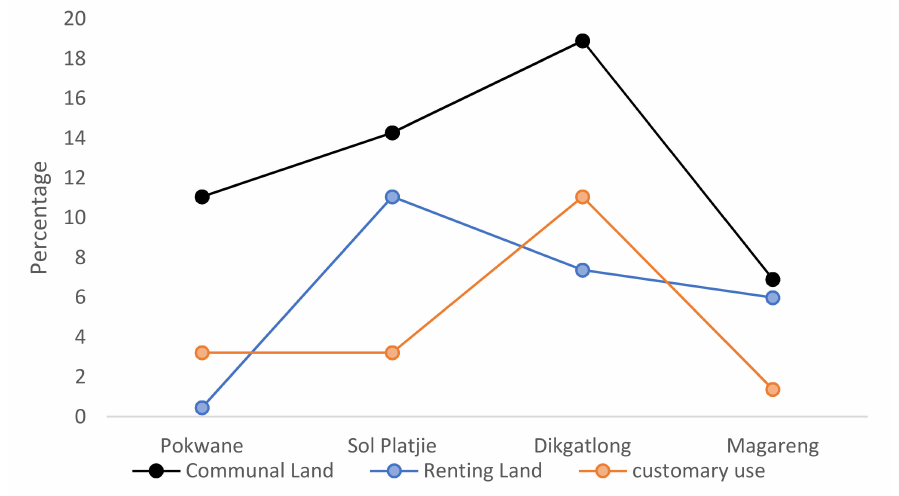
Figure 5. Land tenure for smallholder livestock farmers.